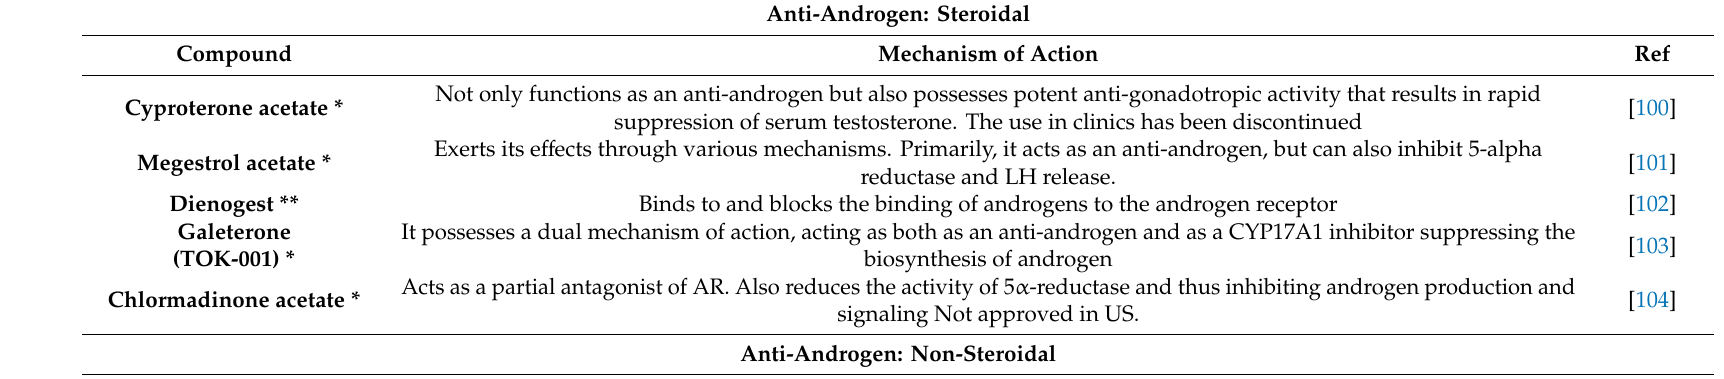
Table 2. List of compounds targeting androgen receptor, and their mechanisms of action (* compounds that are / were in clinical practice, ** compounds that show promise in preclinical studies, but have not yet been evaluated in clinical trials or have yet brought to clinical